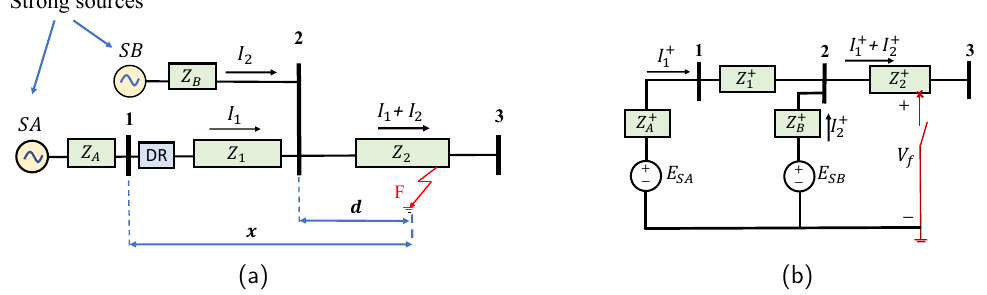
Figure 13. Descriptive figure for Method 3 ( a ) radial distribution feeder; ( b ) the positive-sequence equivalent